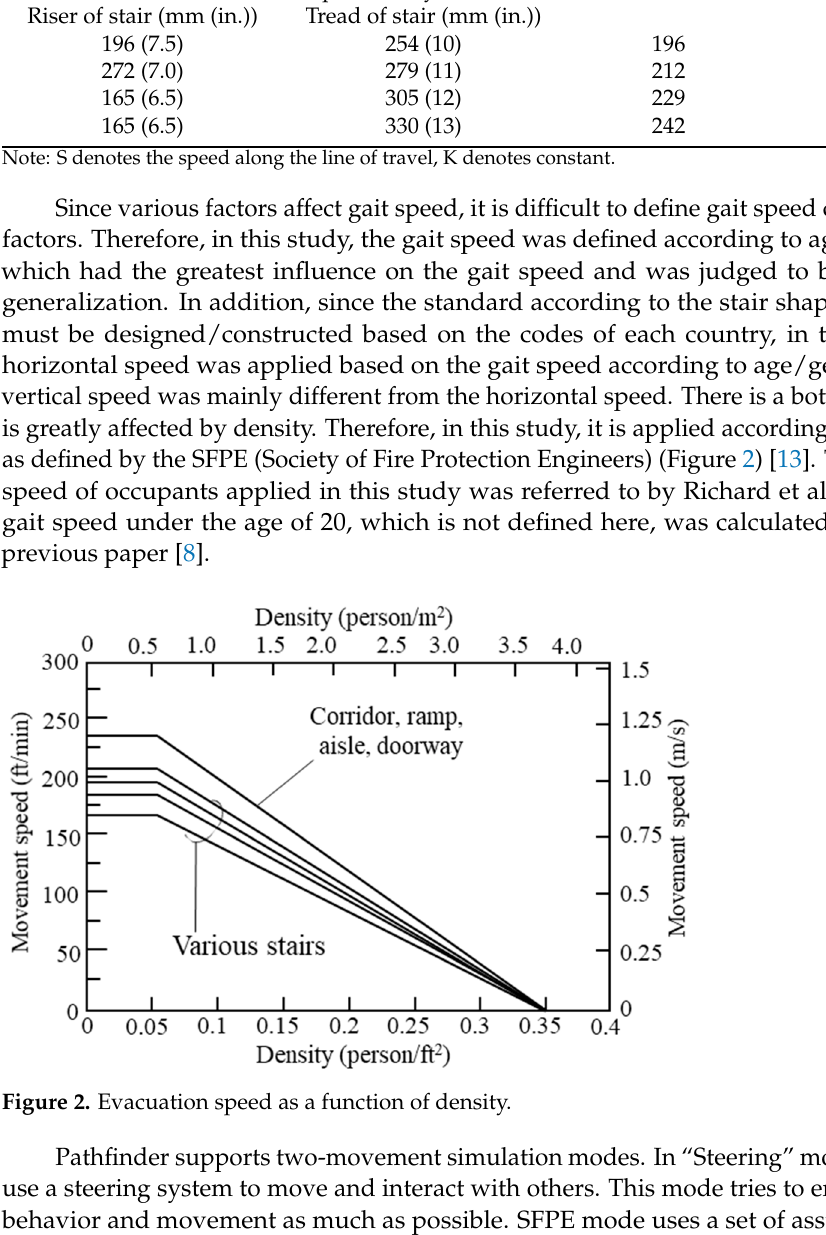
Table 1. Constants for Equation, Evacuation Speed.